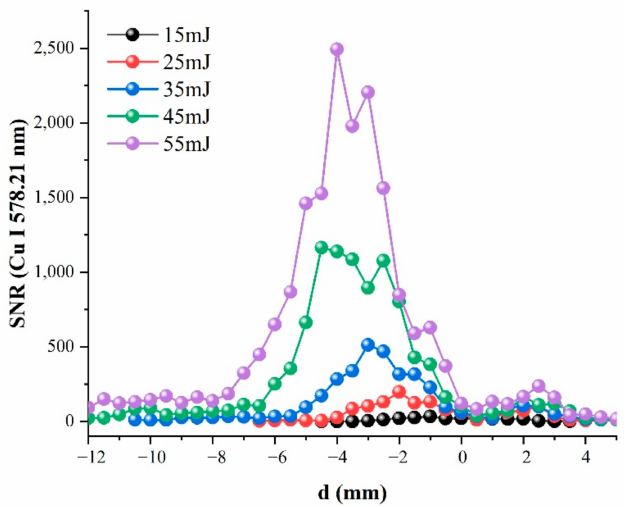
Figure 5. Variation in SNR of Cu(I) at 578.21 nm with d at different pulse